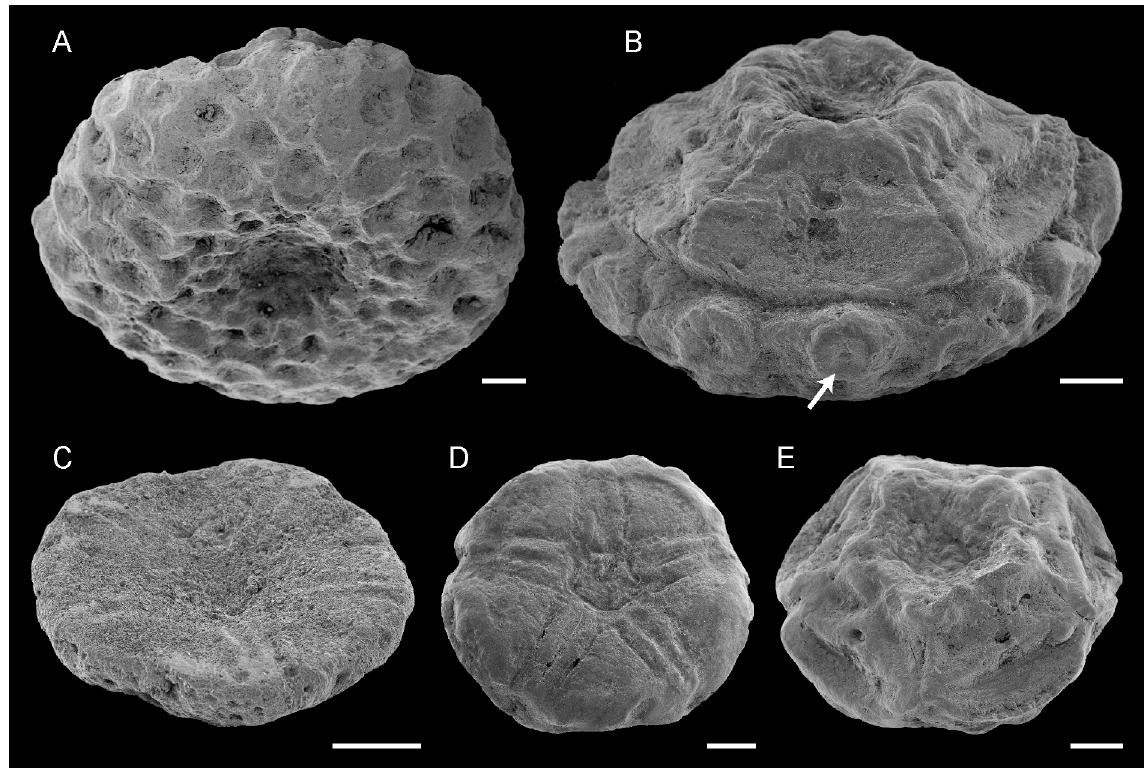
Fig. 5. Late Burdigalian specimens attributed to Discometra rhodanica (Fontannes, 1877) by de Loriol (1897). A–B . Neotype of D. rhodanica from Notre-Dame du Château (MASR 2020.5011). A . Oblique aboral view of centrodorsal. B . Oblique adoral view of calyx (arrow = sub-rectangular low ridge). C–E . Unidentified Comatulidae Fleming, 1928. C . Adoral face of a centrodorsal from Entrechaux – ʻFerme Pieʼ (MHNL 20.062689). D-E . Radial circlet from Notre-Dame du Château (MASR 2020.5021). Scale bars = 1